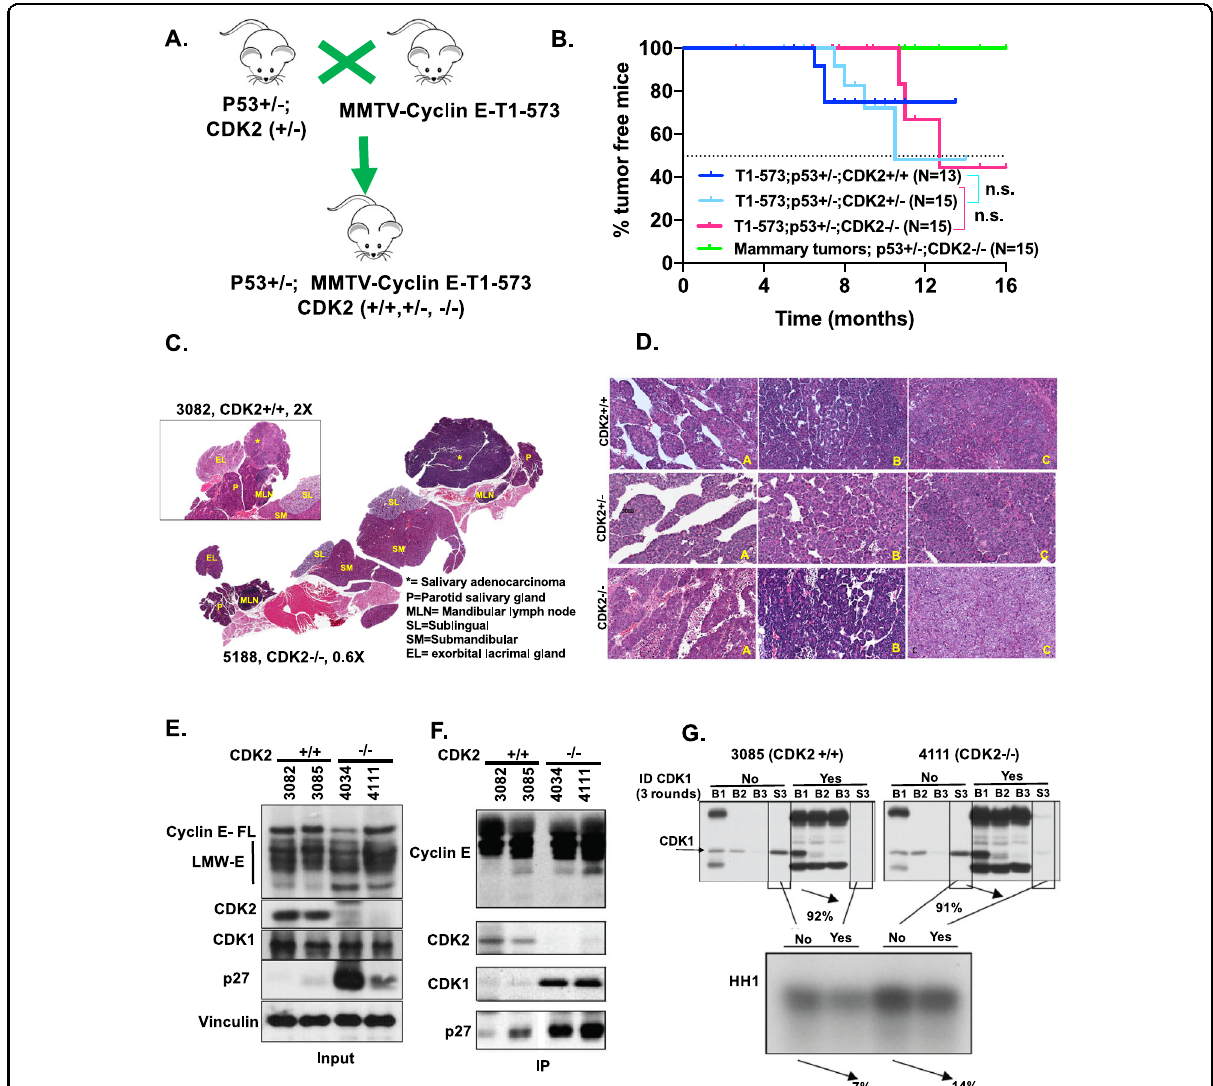
Fig. 1 LMW-E drives salivary gland tumorigenesis, independent of CDK2 status. A Representative cross of transgenic MMTV-LMW-E-T1 and p53 + / − , CDK2 + / − to generate isogenic CDK2 ( + / + , + / − , and − / − ) MMTV-LMW-E-T1-p53 + / − mice. B Percentage of tumor-free mice among MMTV-LMW-E-T1; p53 + / − ; isogenic for CDK2. CDK2 + / + ( n = 13, dark blue line), CDK2 + / − ( n = 15, light blue line) and CDK2 − / − (pink line, n = 12); compared to incidence of mammary tumors (green line, n = 12) in MMTV-LMW-E; p53 + / − ; CDK2 − / − mice. Log-rank Mantel – Cox test was used to compare survival between the indicated genotypes. Samples sizes were estimated using the G power software. Data from our previous publication 17 was used to estimate the differences between different CDK2 backgrounds. Mice were grouped by CDK2 genetic status without a need for randomization. C The murine parotid salivary gland (P) expanded and effaced by an adenocarcinoma (*). Unaffected salivary glands and adjacent structures including the sublingual salivary gland (SL), submandibular salivary gland (SM), exorbital lacrimal gland (EL), and mandibular lymph node (MLN) are shown in a CDK2 − / − tumor (H&E, 0.6×). Inset: murine parotid salivary gland (P) expanded and effaced by an adenocarcinoma (*) in CDK2 + / + tumors (H&E, 2×). D Multiple histologic patterns within individual tumors and between tumors from CDK2 + / + , CDK2 + / − , and CDK2 − / − mice. Typical histologic patterns including trabecular ( A ), acinar ( B ), and solid ( C ) (H&E, 20x). E Input (10%) using 25 μ g protein was subject western blot analysis of salivary gland tumor lysates from MMTV-LMW; p53 + / − ; CDK2 + / + or CDK2 − / − mice for the indicated markers. F Immunoprecipitation (IP) with cyclin E using 250 μ g of salivary gland tumor lysates from ( E ) in MMTV-LMW; p53 + / − ; CDK2 + / + or CDK2 − / − mice, followed by western blot analysis of the indicated markers. G Histone H1 (HH1) kinase assay to measure cyclin E associated kinase activity, with (Yes) or without (No) 3 rounds of immunodepletion (ID) of CDK1 from salivary gland tumor MMTV-LMW; p53 + / − ; CDK2 + / + (3085) or CDK2 − / − (4111) mice. B1 – B3 in both samples corresponds to beads after the fi rst-third round of ID and S3 corresponds to the supernatant protein lysate used after the third round of ID showing >90% ID of